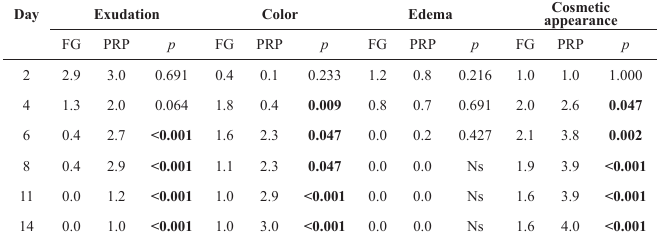
FIGURE 1 – A. CF group. B. PRP group. Note the better cosmetic appearance in CF group.